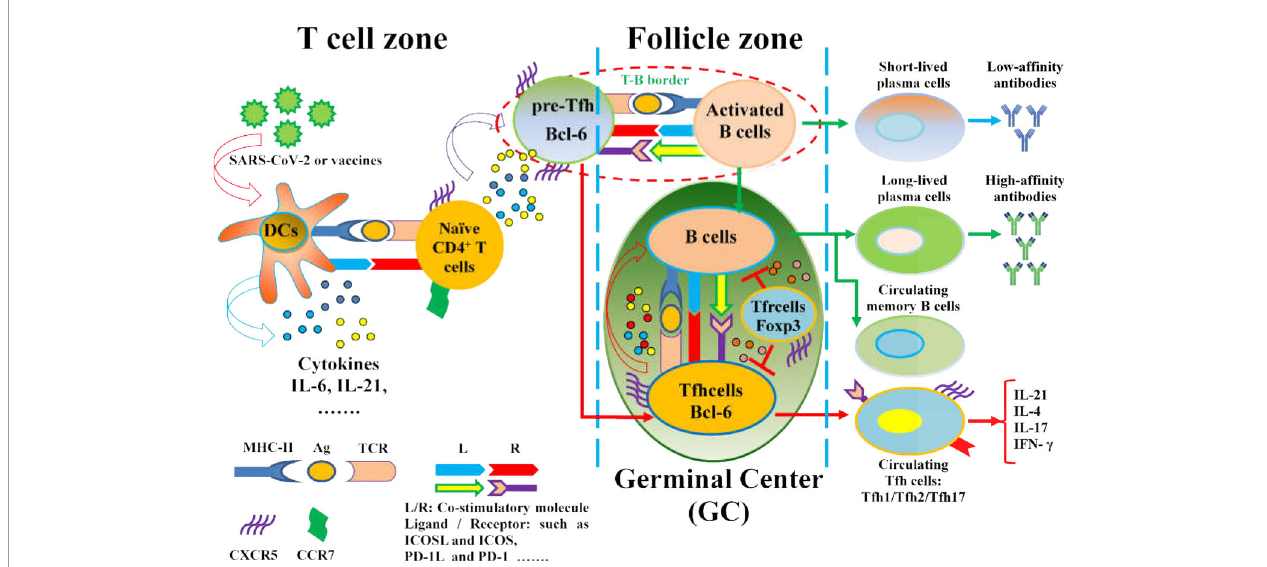
FIGURE 2 | The regulation of Tfh cell differentiation and function in SARS-CoV-2 infection and vaccines. Naïve CD4 + T cells are driven by APCs (DCs) upon exposure to SARS-CoV-2 or virus antigens, which are activated toward antigen-speci fi c Pre-Tfh cells with upregulation of CXCR5 and Bcl-6 and downregulation of CCR7 under the interaction of MHC-II molecules on DCs and cognate TCR on CD4 + T cells, as well as the expression of costimulatory molecules and cytokine production. Pre-Tfh cells interact with activated B cells at the T-B border in the follicle zone, which further differentiate into various Tfh cell subsets that migrate to the GC, where Tfh cells promote B cell differentiation and speci fi c antibody production. However, the loss of GC structures reduces Bcl-6 + Tfh cells in severe COVID-19 patients. Notably, SARS-CoV-2-speci fi c Tfh cells are expanded in mild and asymptomatic patients with COVID-19.Moreover, vaccines can ef fi ciently induce Tfh cell differentiation, GC formation, and protective antibody